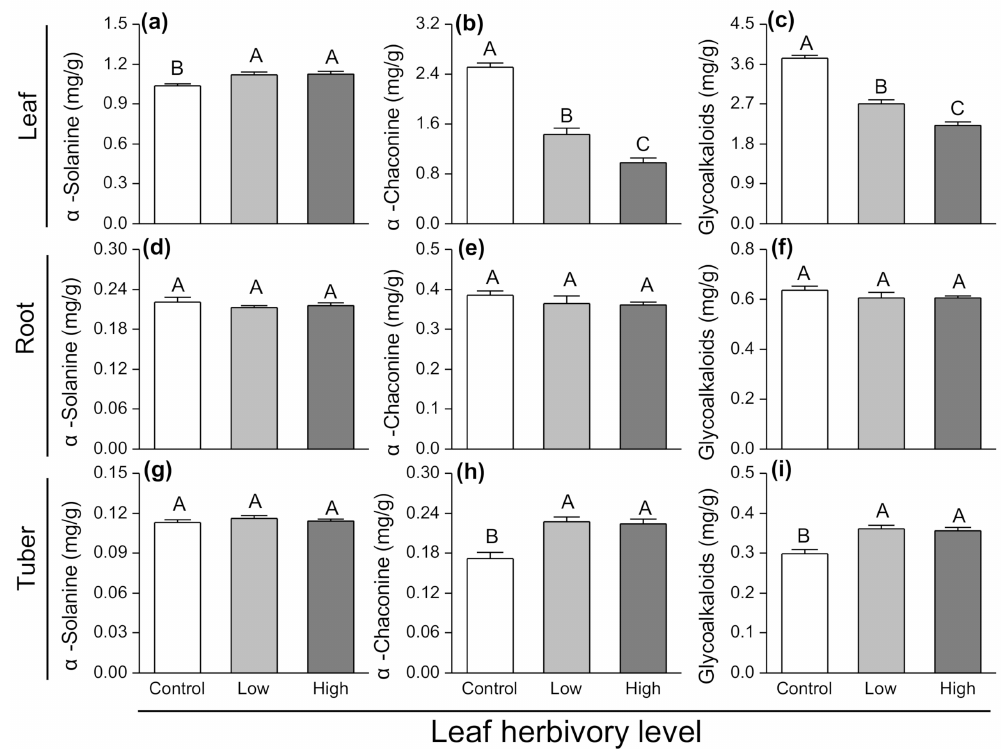
Figure 5. Changes in ( a – c ) α -solanine, ( d – f ) α -chaconine and ( g – i ) glycoalkaloid contents in di ff erent plant components (leaf, root and tuber) of potato plants exposed to di ff erent herbivory levels of Phthorimaea operculella . Data are means ± SE. Di ff erent letters indicate significant di ff erences among treatments ( p < 0.05) based on post hoc Tukey’s HSD